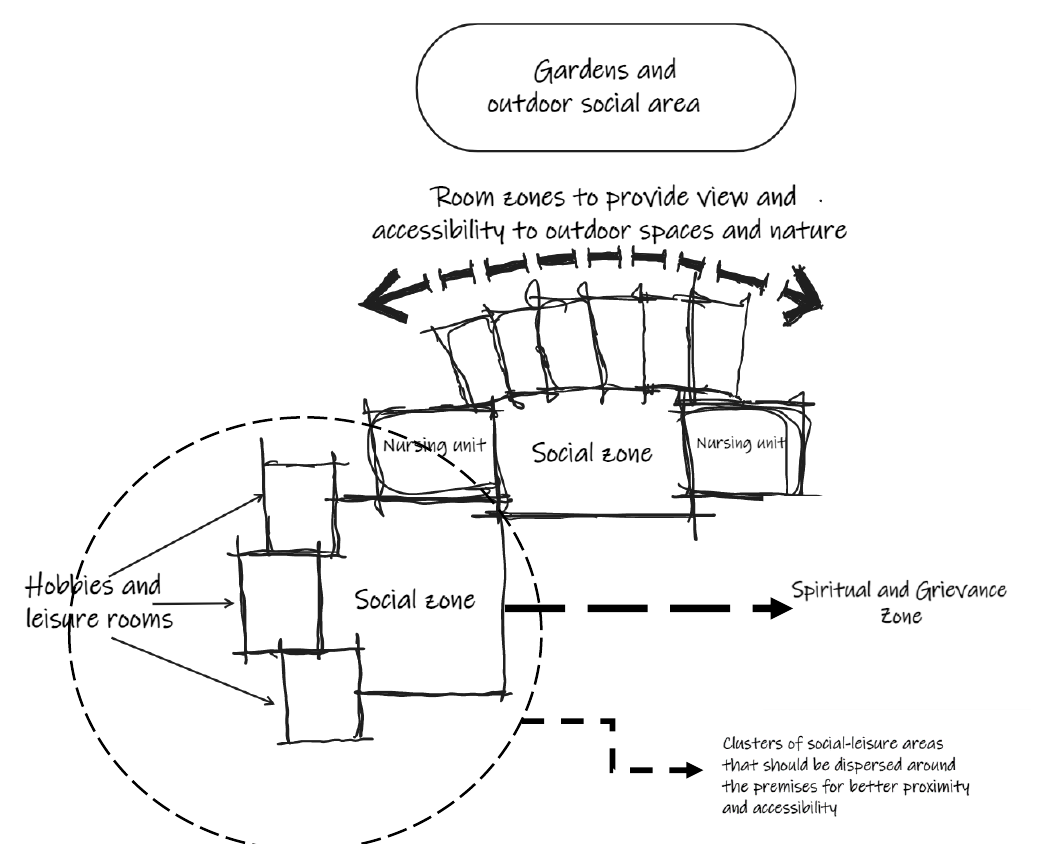
Figure 7: conceptual design of design relation between patient rooms, social areas, and nursing units and accessibility to the outside